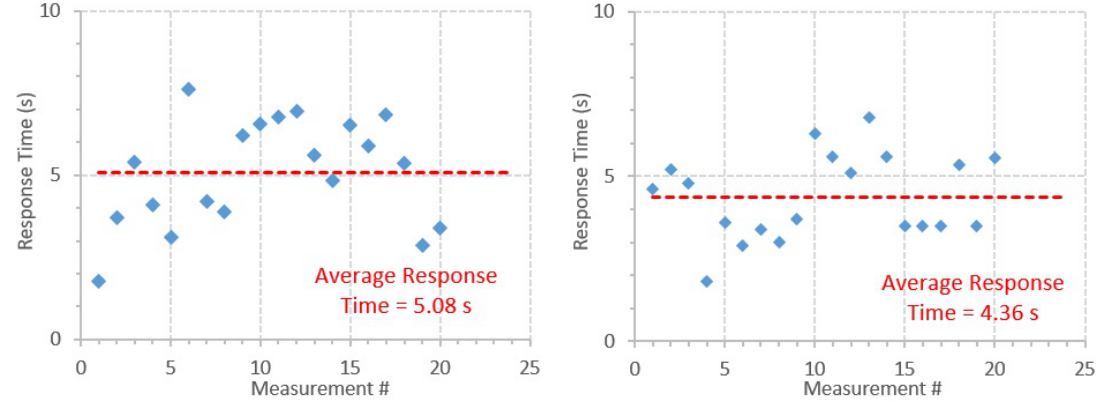
Figure 11. Detector response time for each measurement exposing the Sparkfun ( left ) and the Mazur ( right ) detectors to two Cs-137